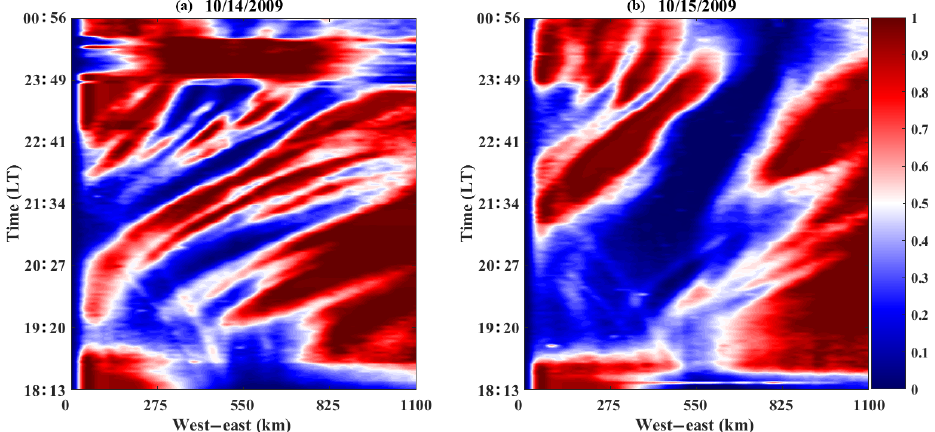
Figure 9. Keograms for 14 October 2009 (a) and 15 October 2009 (b) .